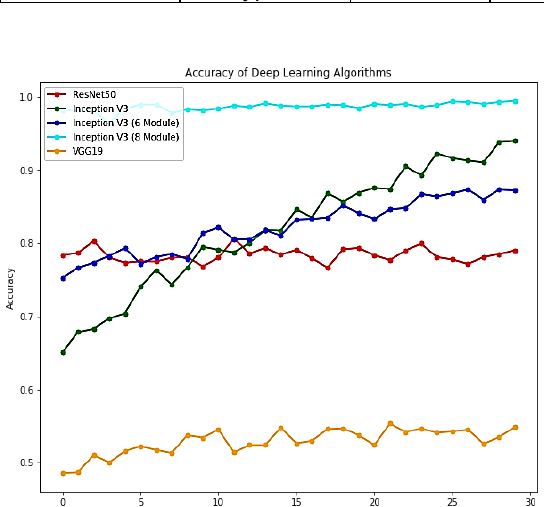
Figure 6. Accuracy of Models on Test